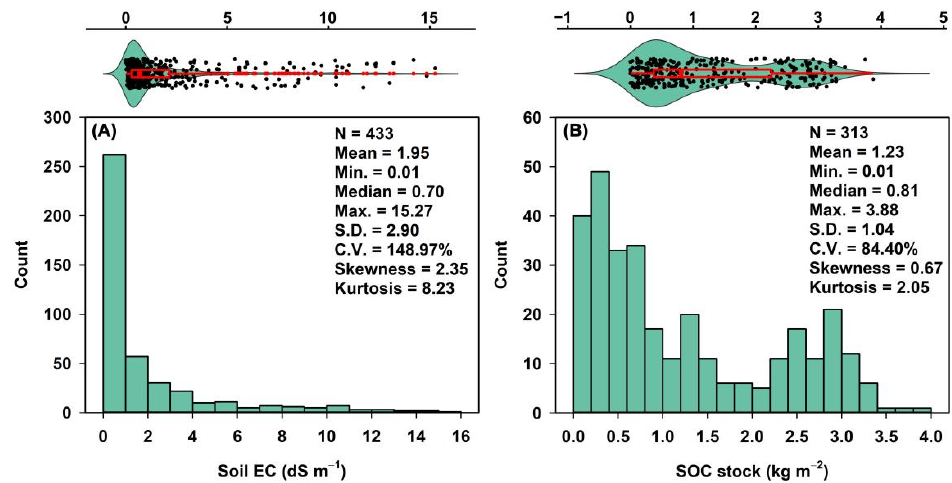
Figure 4. Histogram and statistics of soil EC ( A ) and SOC stock ( B ). Note: N, Min, Max, S.D., and C.V. represent the sample size, minimum, maximum, standard deviation, and coefficient of variation, respectively.